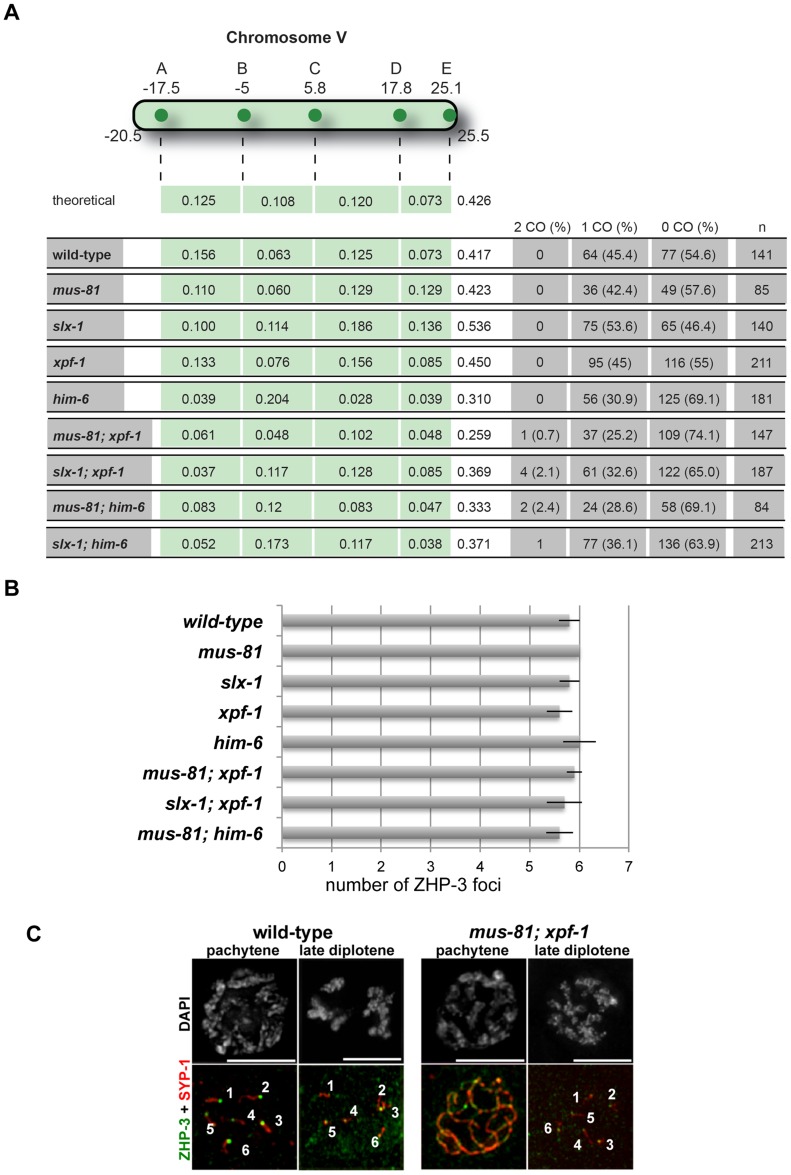
Despite showing reduced crossover recombination frequencies, wild-type numbers of ZHP-3 foci are detected in [mus-81; xpf-1] and [slx-1; xpf-1] double mutants.(A) Measurements of CO recombination frequency and distribution between five snip-SNPs, highlighted as A to E, was scored on Chromosome V. The genetic map position of the SNP used is indicated. n is the number of cross-progeny scored. The frequency of 2 COs, 1 CO or 0 CO per chromosome is indicated in absolute numbers and as percentage (in brackets). (B) Quantification of α-ZHP-3 foci in pachytene/diplotene nuclei (a minimum of 8 nuclei was scored per genotype). (C) Representative images of SYP-1 (red), ZHP-3 (green) stainings.